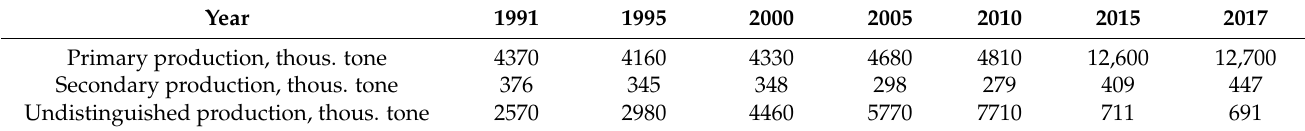
Table 10. Total zinc production broken down into primary and secondary zinc production and non-differentiated production in thousands of tons, based on data from